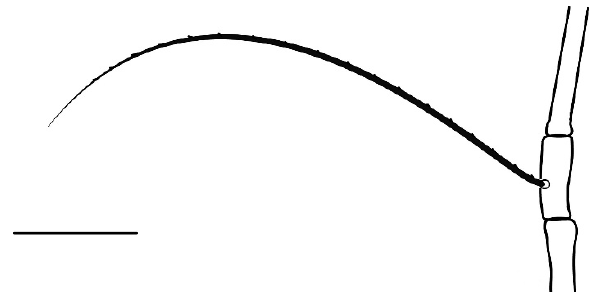
Figure 14. Neophyllobius fissus . Female. Genu I. Scale bar: 50 μ m.